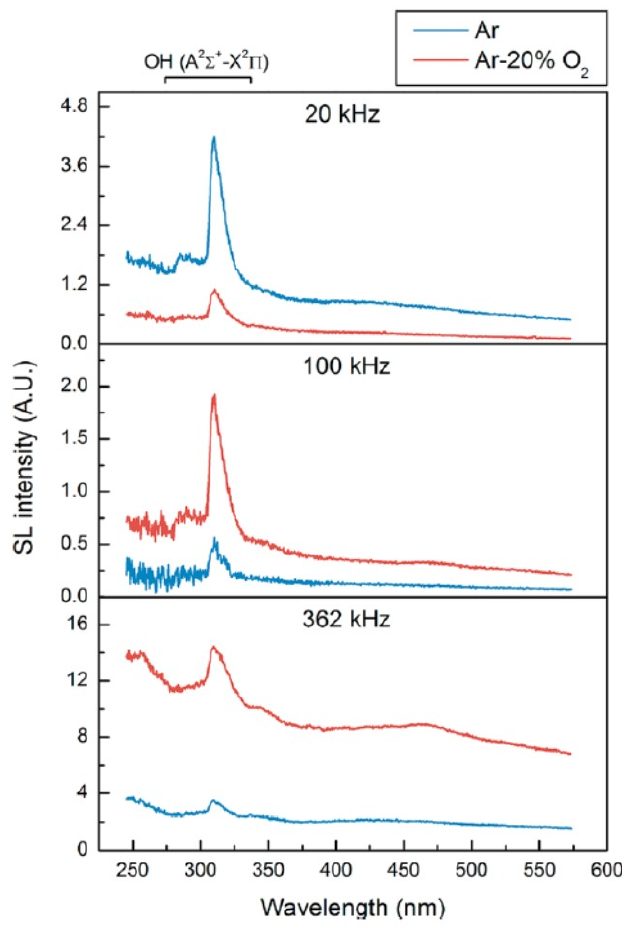
Figure 12. MBSL spectra of water at 20 kHz with 33 W, 100 kHz with 40 W, and 362 kHz with 43 W at 18 ◦ C [46]. The apparent broad peak around 400–475 nm at 362 kHz is an artifact due to second-order light emission of the strong MBSL UV part. Copyright 2018, with the permission from American Chemical Society.